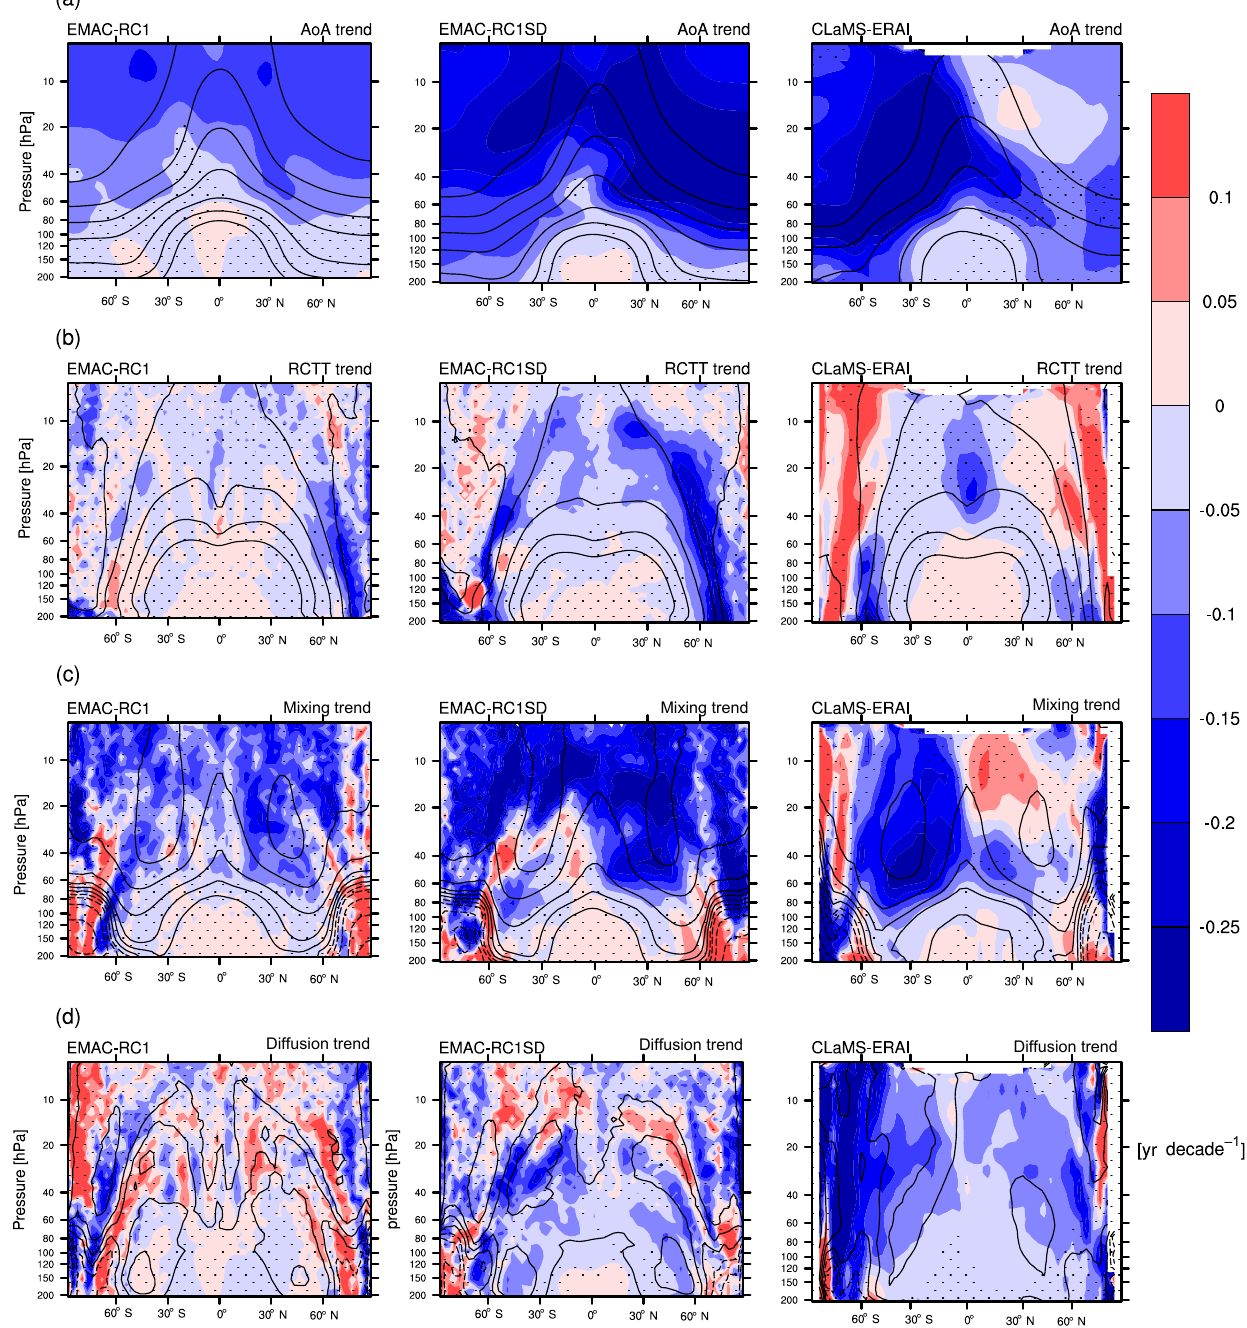
Figure 7. Trends for 1990–2011 of (a) AoA, (b) RCTT, (c) resolved aging by mixing and (d) aging by diffusion for the simulations EMAC- RC1 (left), EMAC-RC1SD (middle) and CLaMS-ERAI (right). Black contours show climatological values. Stippling displays regions where trends are not significant on a 95% level. Units are given in yeardecade − 1